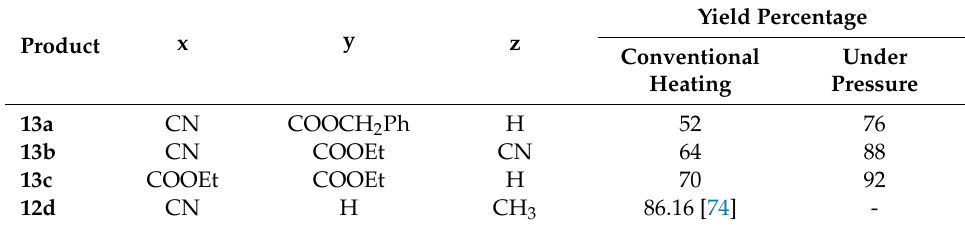
Table 2. Reaction yield for 13a–c and 12d under pressure and conventional heating.